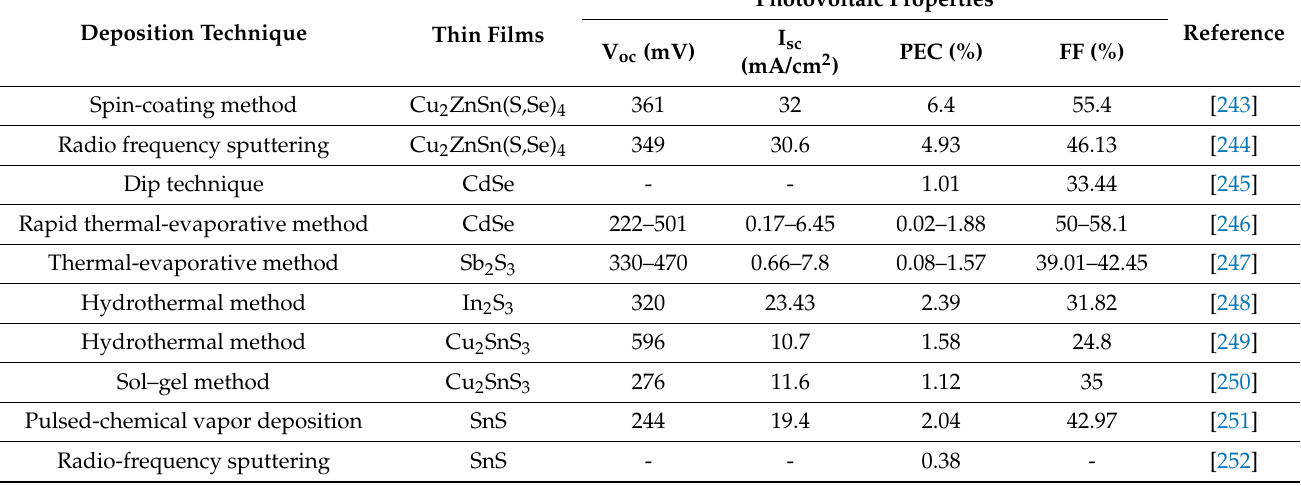
Table 6. The growth of different types of thin films using various deposition methods and the photovoltaic